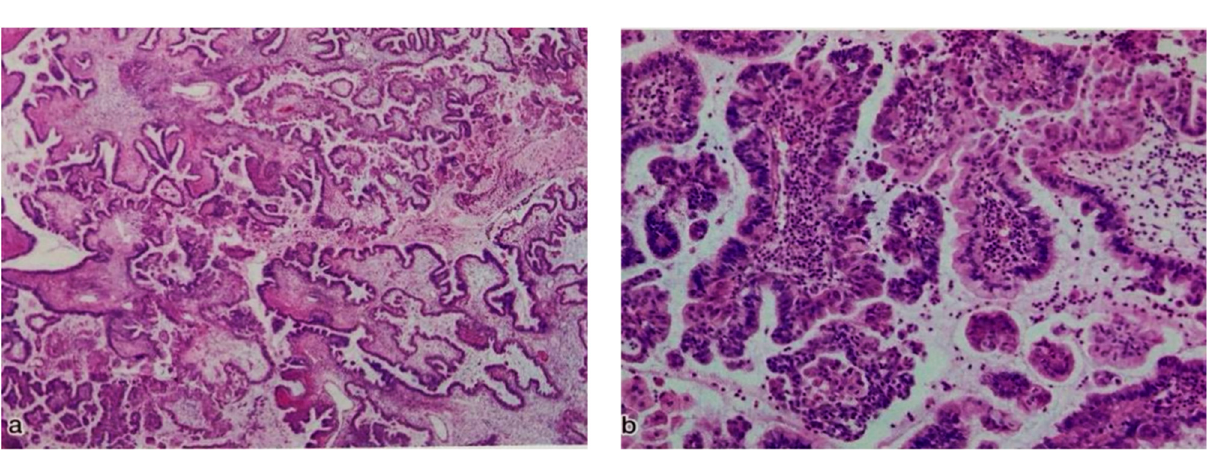
Figure 1. Representative histological characteristics of seromucinous borderline tumor (SMBT). ( a ) Low magnification (×10); ( b ) high magnification (×20).